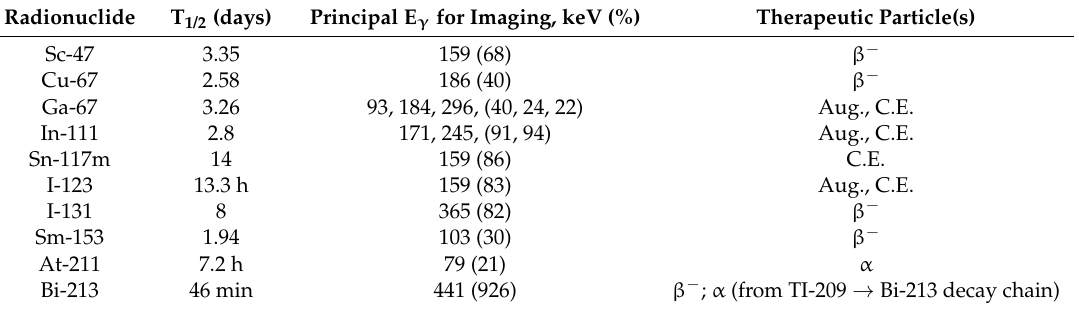
Table 4. Theranostic radionuclides